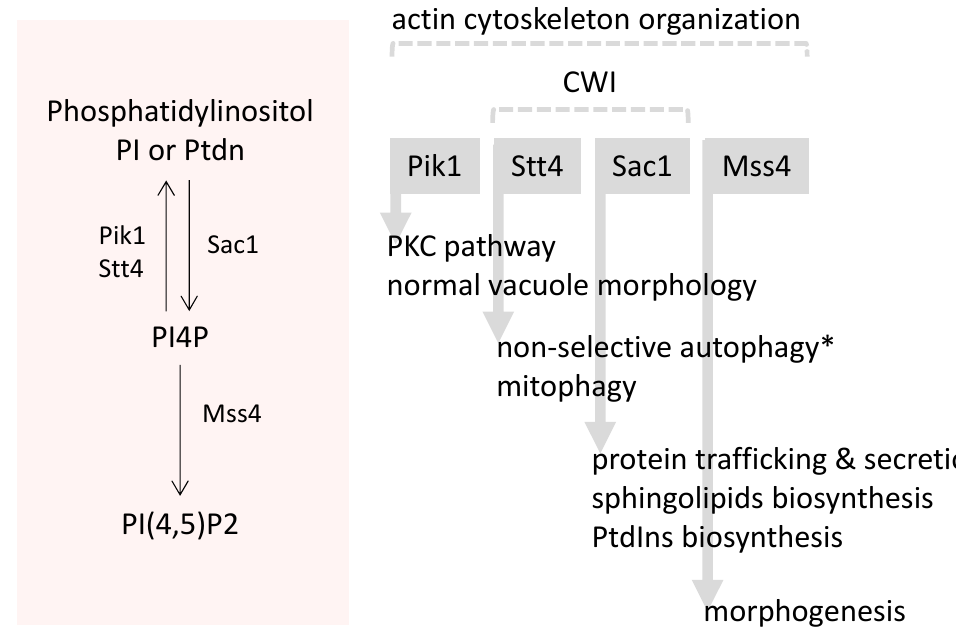
Figure 4. Phenotypes associated to the enzymes known to catalyse the steps from PI to PI(4,5)P2 in S. cerevisiae . These phenotypes are also associated with the GUP1 deletion, with the exception of mitophagy. * Preliminary results [45].